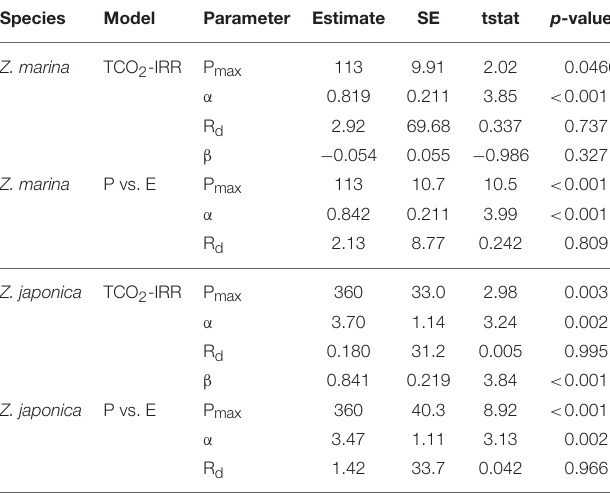
TABLE 2 | Predicted photosynthetic parameters from the TCO 2 -irradiance (TCO 2 -IRR) model (Equation 3) and the standard photosynthesis-irradiance ( P vs. E ) model (Equation 1). Species